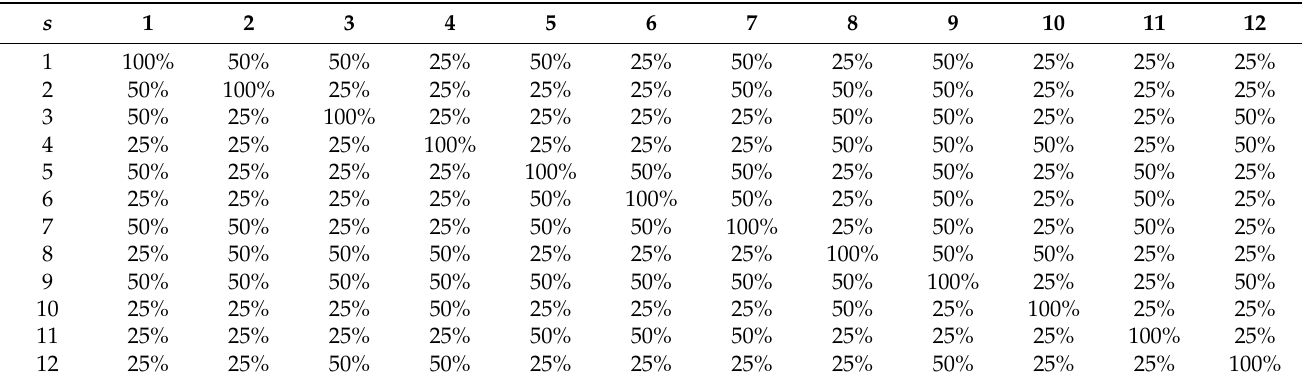
Table 2. Correlation matrix between segments ( CorrNonlife ( i , j )